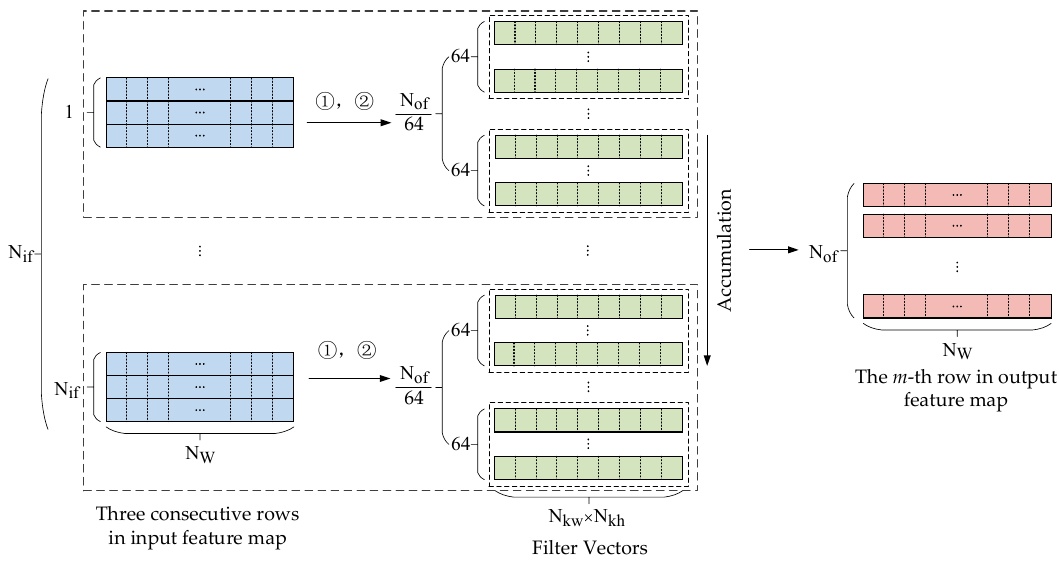
Figure 10. The detailed calculation process for generating the m- th row of the output feature map in each convolutional layer. 1 (cid:79) refers to vectorization. 2 (cid:79) is vector inner product.